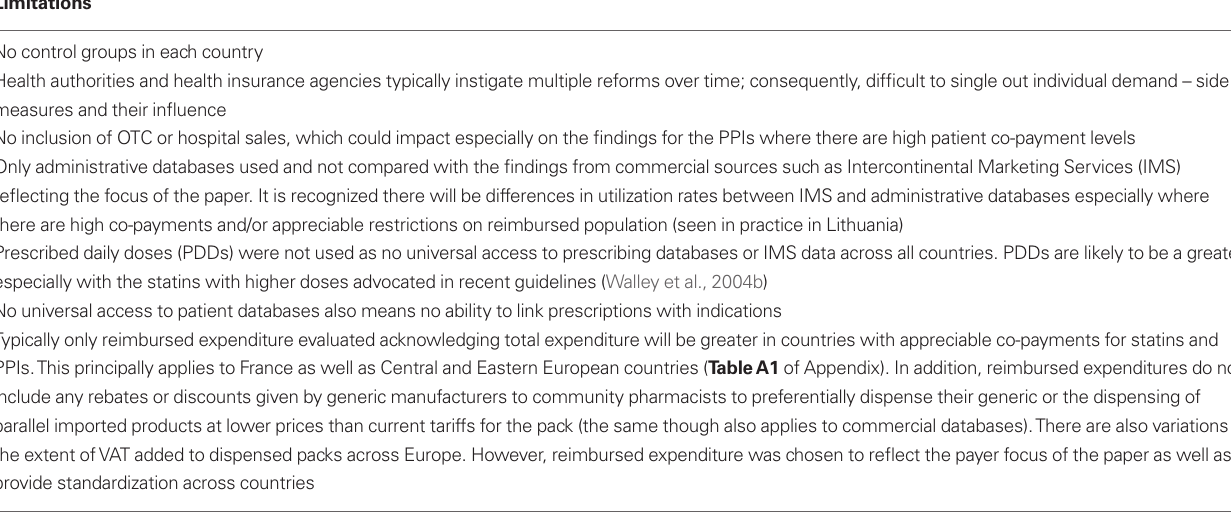
Table 5 | Limitations with the study design and rationale for some of the